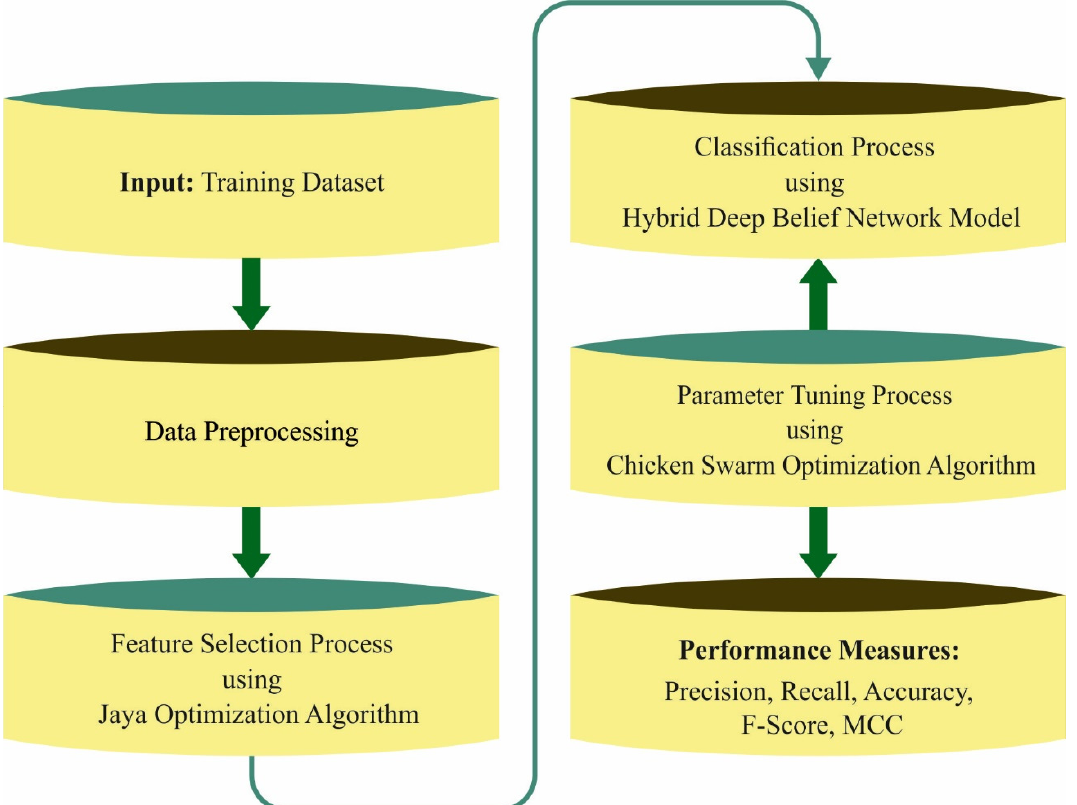
Figure 1. Overall process of FSHDBN-CID approach.